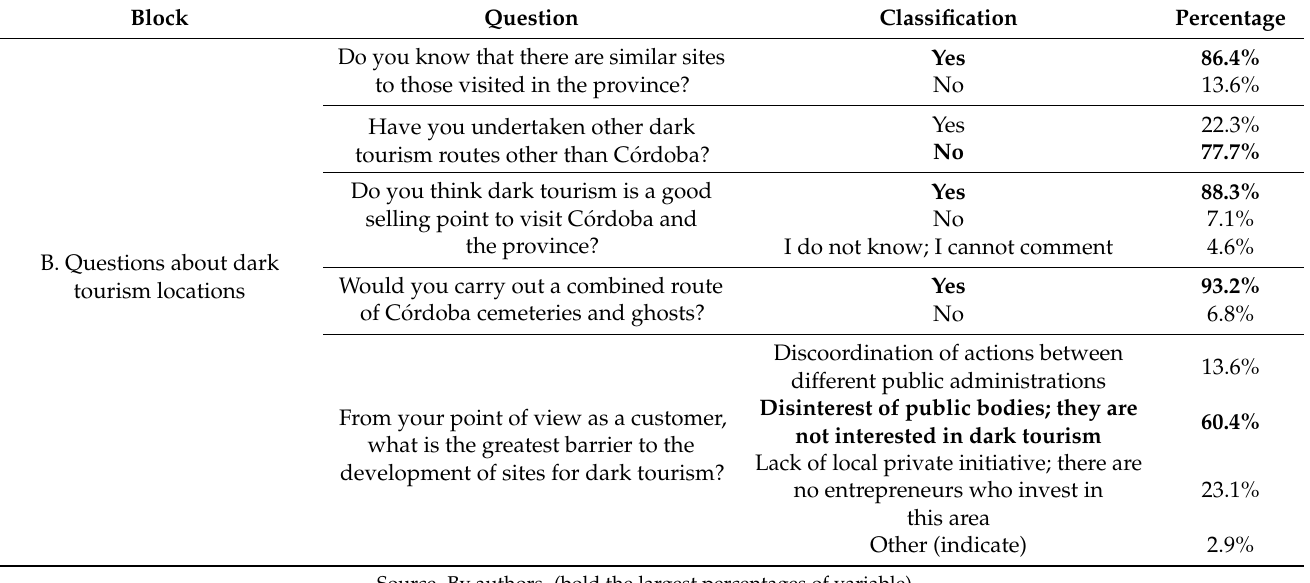
Table 5. Univariate results of the survey of dark tourists in C ó rdoba: Questions about dark tourism locations.